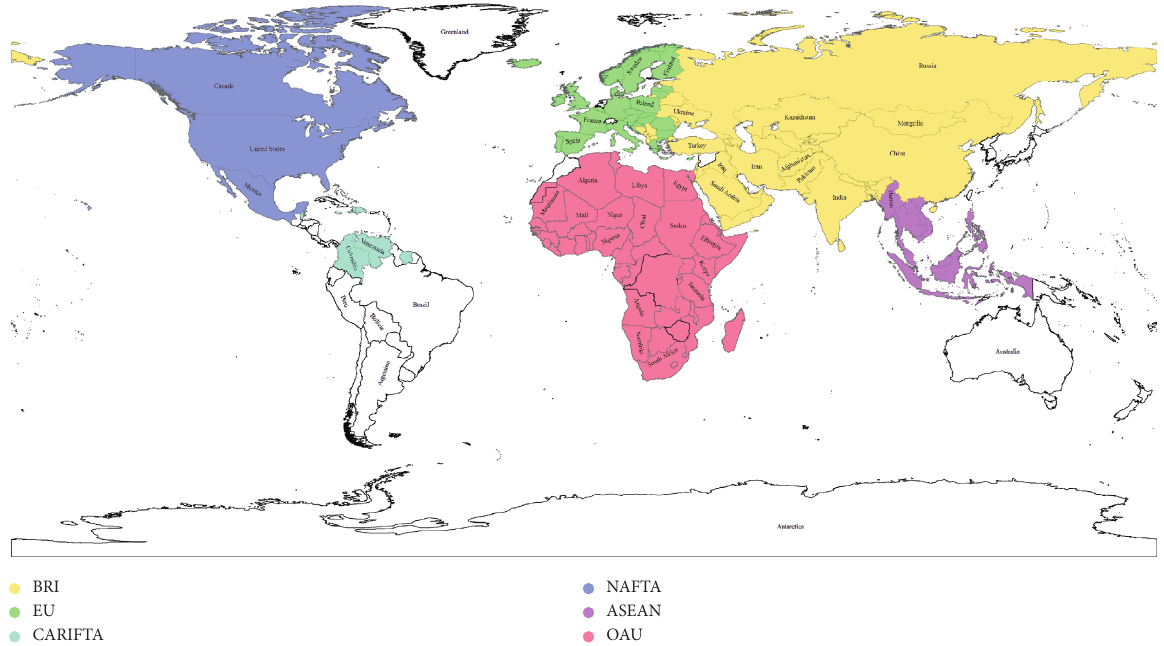
Figure 3: The map of six trade unions (RTAs). They have 155 members, covering nearly 66.5% of the countries and around 69.4% of the trade flows, involving 5 continents and occupying a large area of the